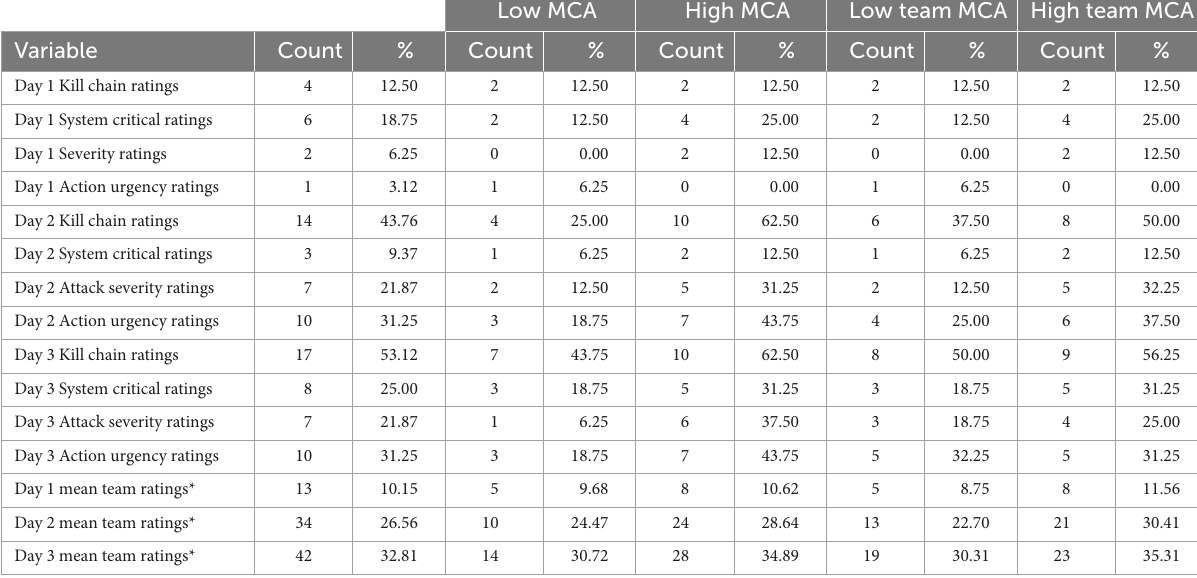
TABLE 4 Number and percentage of correct CSA answers for each day ( N =